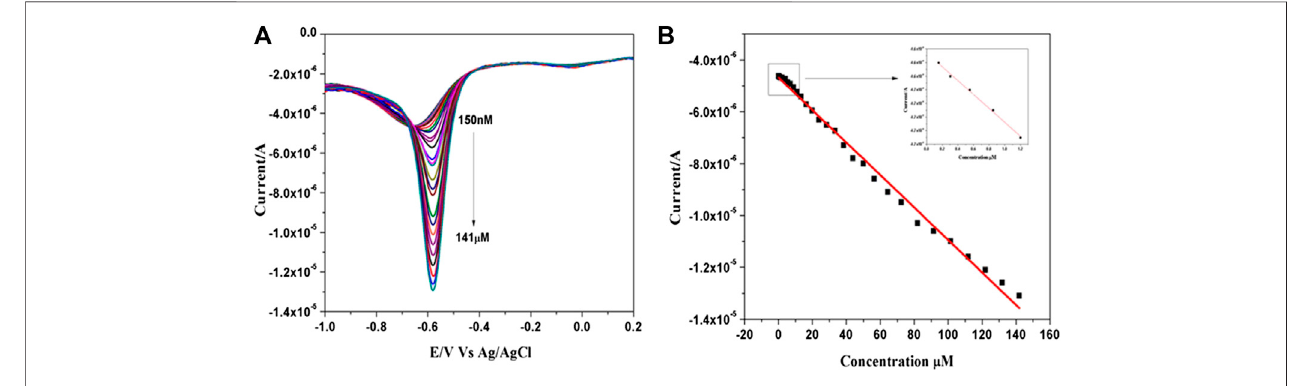
FIGURE 2 | (A) SWVs recorded for various concentration of MP ranging from 0.15 to 141 µM in 0.1 M PBS (pH 7.0) at ß-TCP/GCE. (B) Corresponding linear calibration plot.